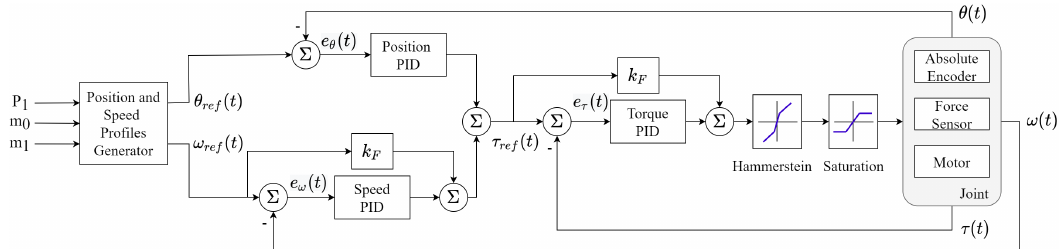
Figure 17. Full compliant controller block diagram.